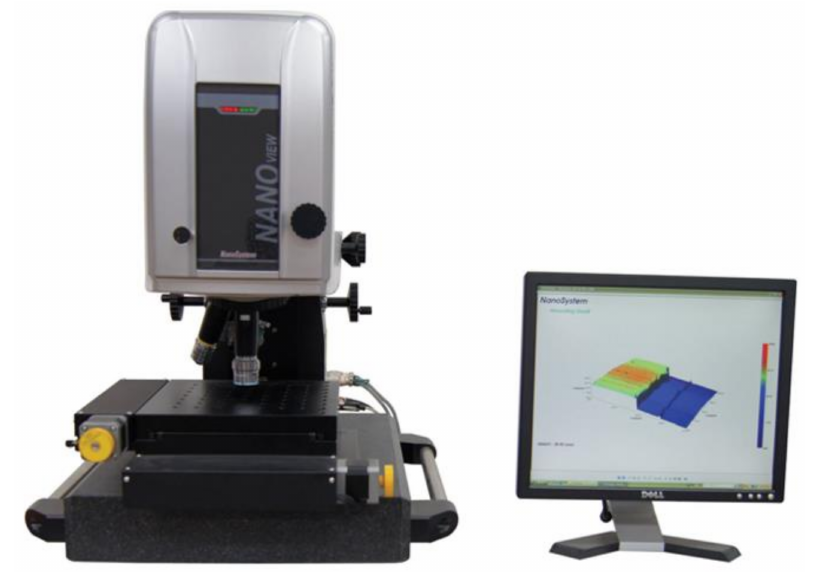
Figure 2. Non-contact three-dimensional surface profiler,